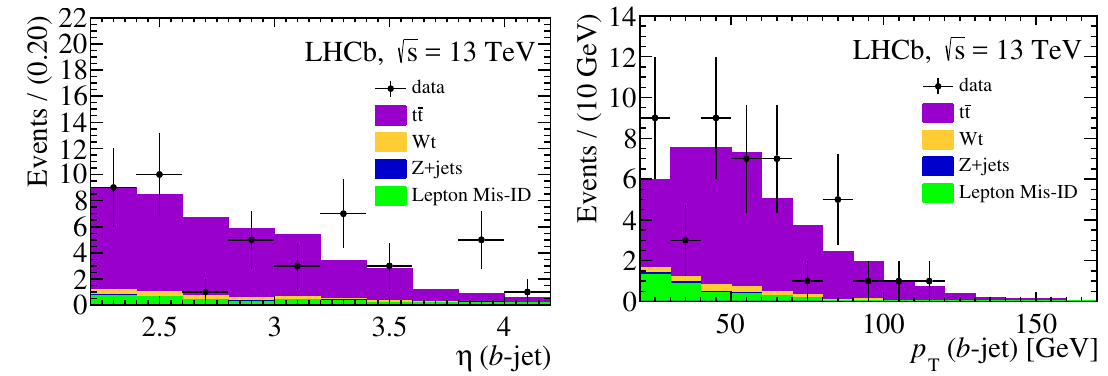
Figure 3 . The b -jet (left) (cid:17) and (right) p T distribution in data compared to the expected contri- butions. The tt signal yield is determined to be the number of selected events minus the sum of the expected backgrounds. The multiboson background is determined to be negligible.